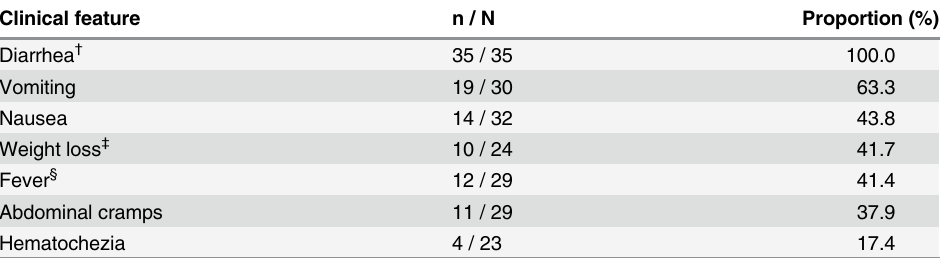
Table 2. Clinical features of cryptosporidiosis cases, Nunavik, April 2013 to April 2014. “ n ” denotes number of cases with a given clinical feature, “ N ” the number of cases for which information was